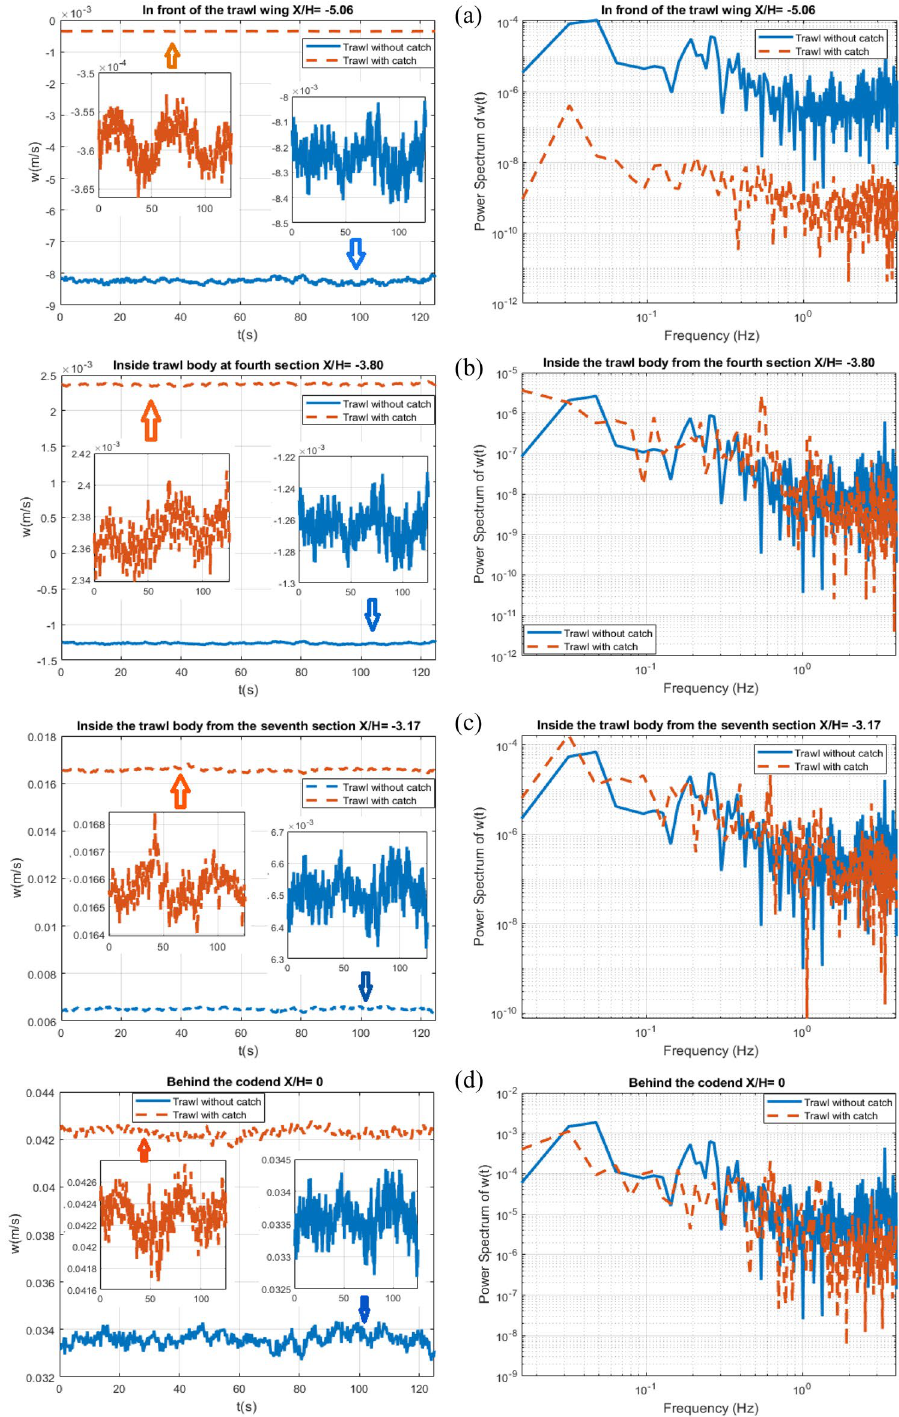
Figure 13. Time evolution of the transverse velocity (right) linked to the normalized frequency spectrum (left in a log–log scale) at ( Y/H = 0 and Z/H = 0.506 ) represented as: ( a ) In front of the trawl wing ( X/H = − 5.06) , ( b ) Inside the fourth section of trawl body ( X/H = − 3.80) , ( c ) Inside the seventh section of trawl body ( X/H = − 3.17) , and ( d ) Behind the codend ( X/H =